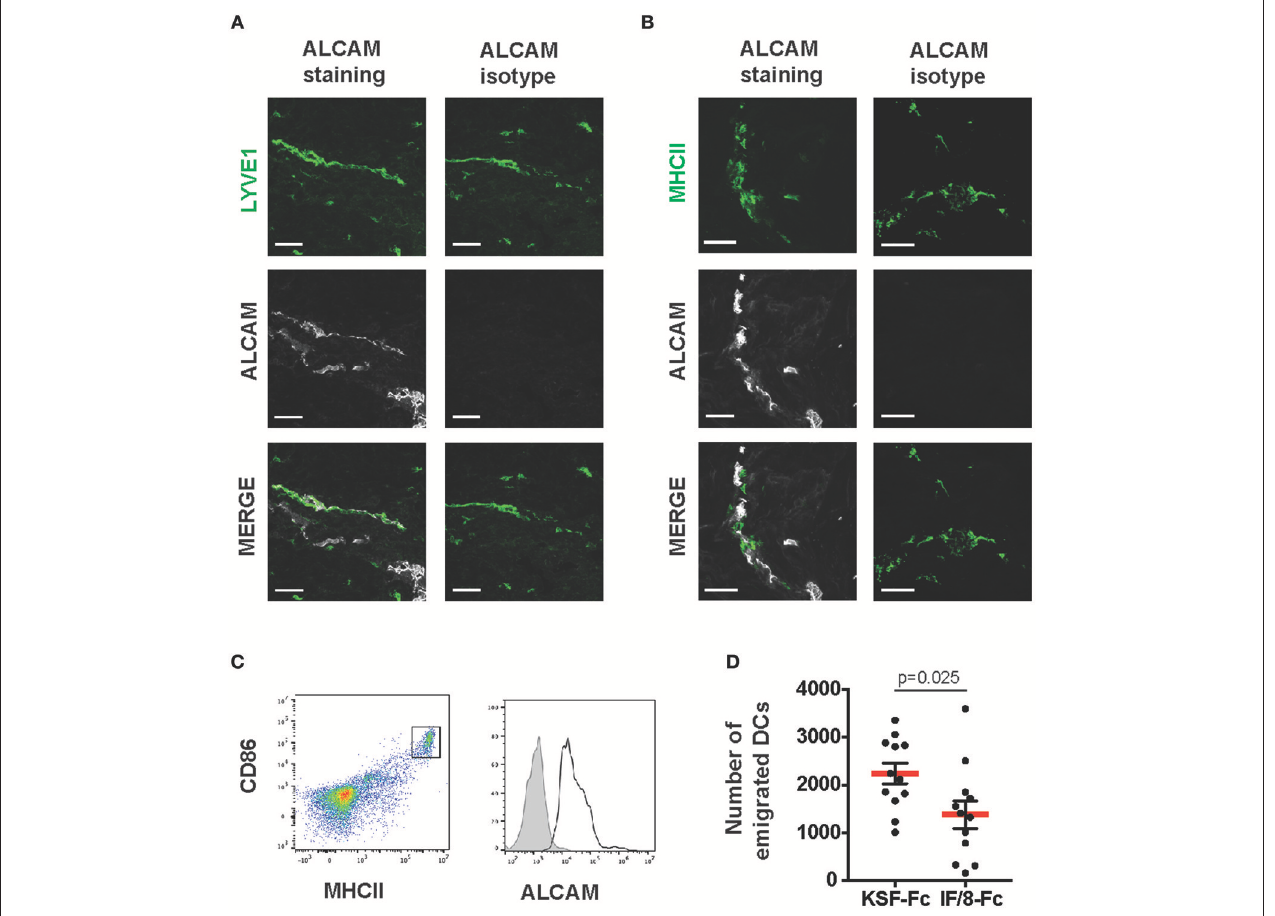
FIGURE 7 | ALCAM blockade reduces DC emigration from human skin. Human skin sections were stained for (A) LYVE-1 and (B) MHCII, in combination with either an ALCAM-specific or the corresponding isotype control antibody. ALCAM reactivity was observed in (A) all LYVE-1 + vessels and (B) in some MHCII + cells. Scale bars: 50 µ m. (C) Human skin punch biopsies were incubated in culture medium and the presence of ALCAM on emigrated CD86 + MHCII hi cells was analyzed after 24h. Data from 1 representative of a total of 3 experiments are shown. (D) Human skin DC emigration experiment. Punch biopsies of human skin were incubated in culture medium in presence of either I/F8-Fc or of KSF-Fc control antibody, and cells emigrated into the culture medium were analyzed by FACS 24h later. In (C) representative FACS plots show the gating scheme. Migratory DCs were identified as CD86 + MHCII hi cells and were quantified with the help of counting beads. Each dot represents one biopsy ( n = 10 per